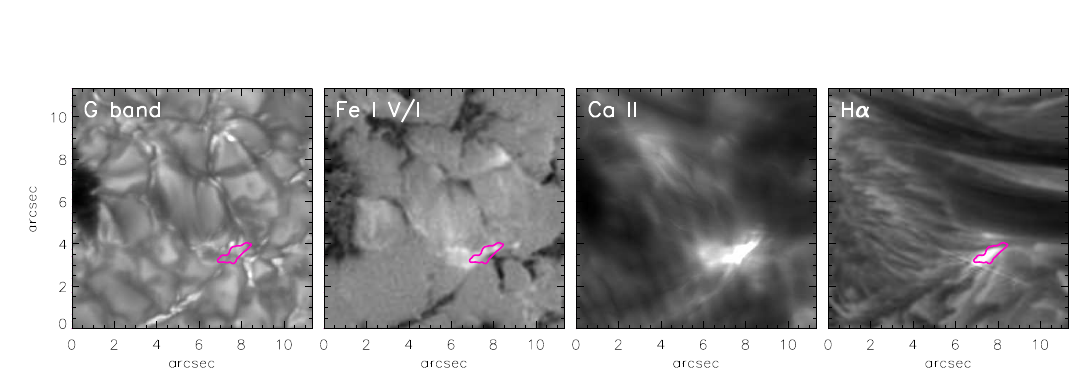
Figure 1: Observation of a small-scale emerging flux event within an active region. The left two panels show the G-band intensity and Stokes V signal from the photosphere. The right two panels show the chromospheric intensity in H 𝛼 and Ca ii H. Image reproduced with permission from Guglielmino et al. (2010), copyright by AAS.